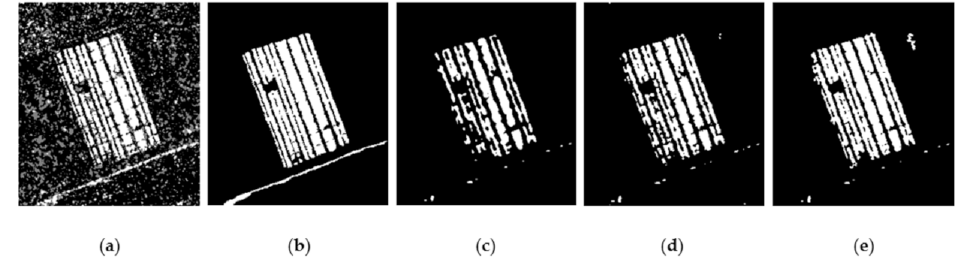
Figure 7. Result at two stages. ( a ) Image (cid:102) DI the pixels in white, black, and gray colors denote changed, unchanged, and uncertain areas, respectively. ( b ) Ground truth. ( c ) The first label used at stage 1. ( d ) Output of stage one, which will be used for stage two. ( e ) Output of stage two (final change